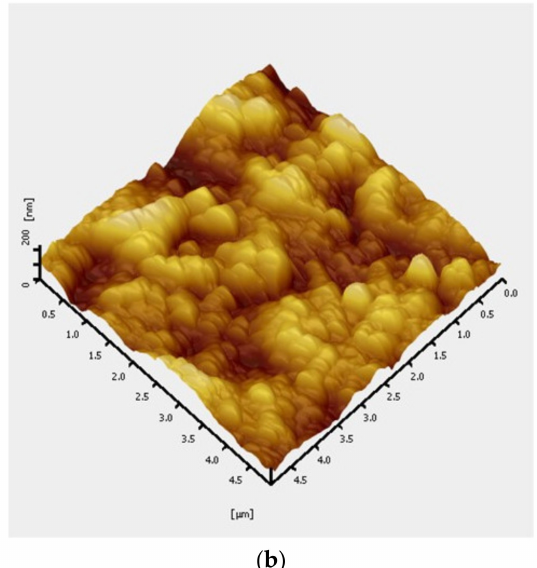
Figure 7. The 3-dimensional AFM image for ( a ) 2 wt% and ( b ) 20 wt% of CuSe filler in CH/Na/CuSe polymer matrix.